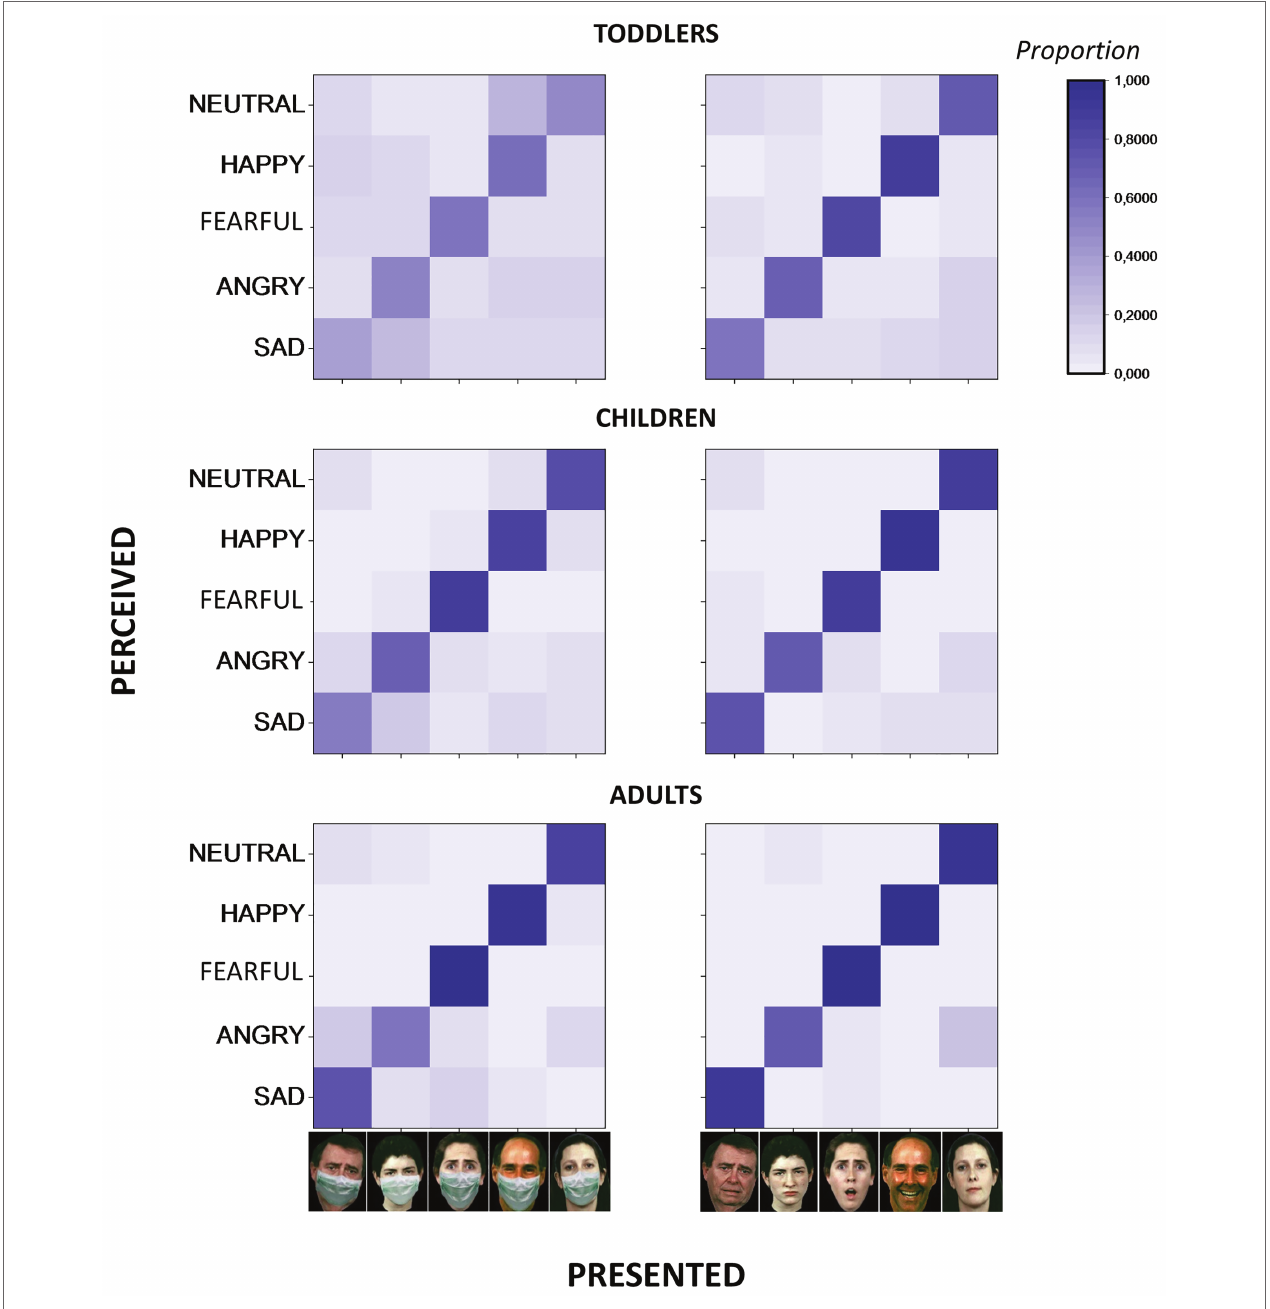
FIGURE 3 | Confusion matrices for emotion inference from facial configurations with (left) and without (right) face masks for the three age groups. On the x -axis, presented stimuli. On the y -axis, emotion perceived by participants. The proportion of responses is reported as a color map. Face images have been obtained from the ER-40 color emotional stimuli public database (Gur et al., 2002; Pinkham et al.,